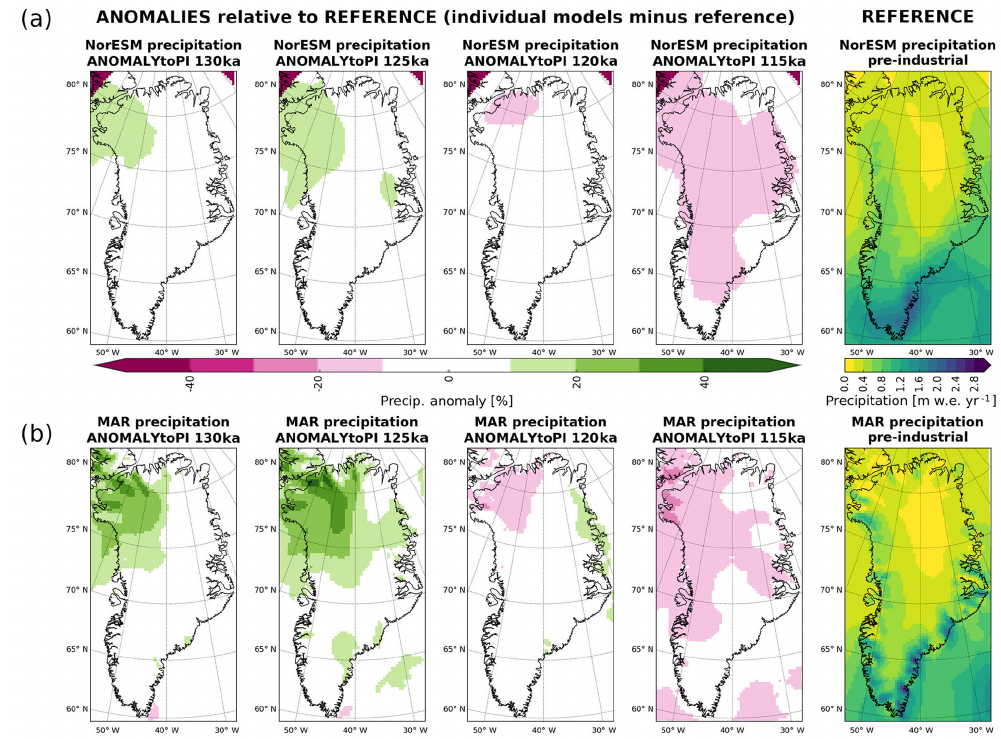
Figure 11. Evolution of the simulated annual precipitation during the Eemian interglacial period. NorESM precipitation is shown in row (a) and MAR precipitation in row (b) . Eemian time slices are shown as anomalies relative to the pre-industrial